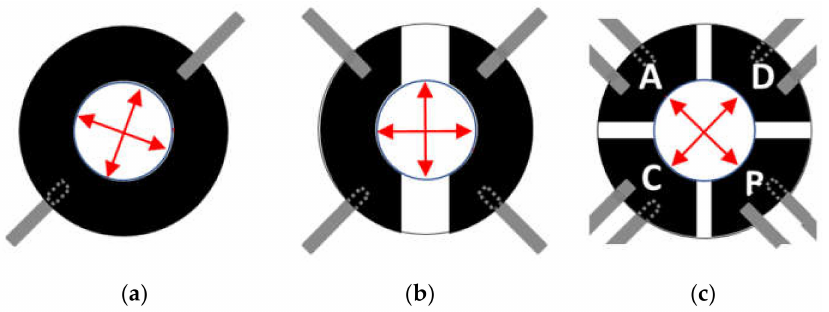
Figure 4. Top-view scheme of the device showing the different electrode configurations tested and the directions along which the components of the strain tensor were calculated: ( a ) annular (i.e., one pair of annular electrodes, in this case two perpendicular directions were randomly selected), ( b ) two-electrode (i.e., two pairs of partial annular electrodes); ( c ) four-electrodes (i.e., four pairs of partial annular electrodes denoted with A, B, C, and D,